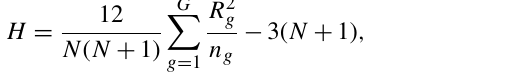
Figshare (https://doi.org/10.6084/m9.figshare.20552745.v1; Pons and Faranda,